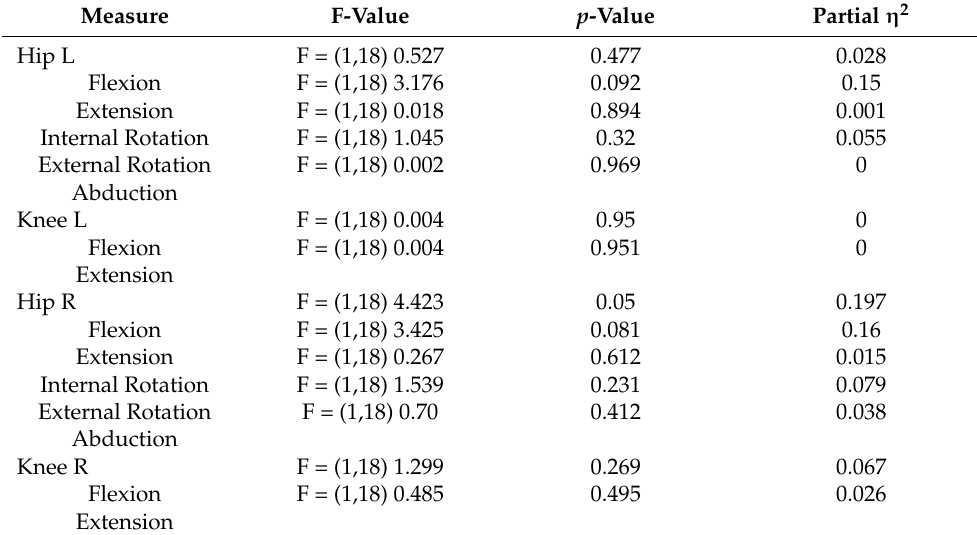
Table 7. Overview of the MANCOVA results.